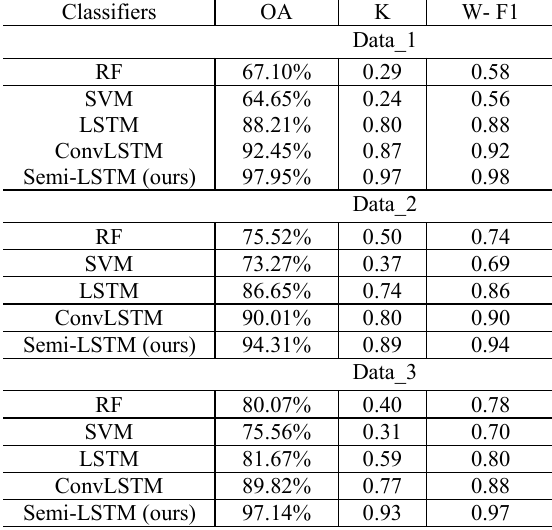
Table 1. Overall accuracy (OA), kappa coefficients (K) and weighted F1 score (W-F1) achieved by various classifiers in three study